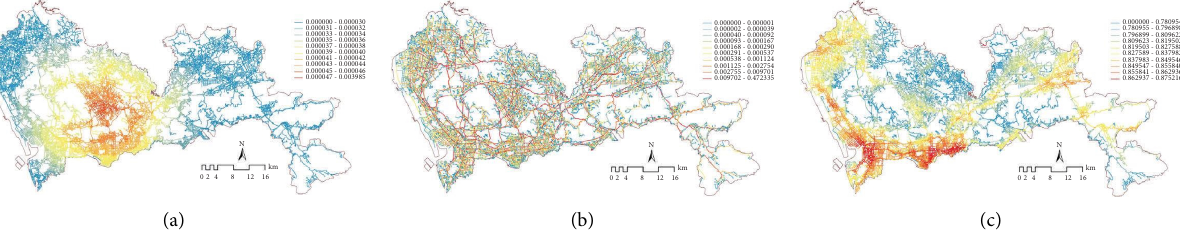
Figure 11: Global centrality spatial distribution of Shenzhen. (a) Closeness centrality. (b) Betweenness centrality. (c) Straightness